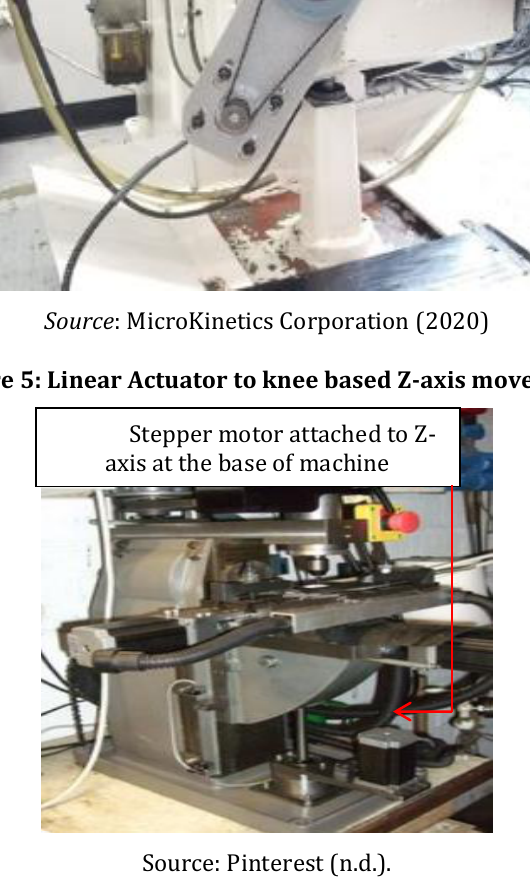
Source: Pinterest